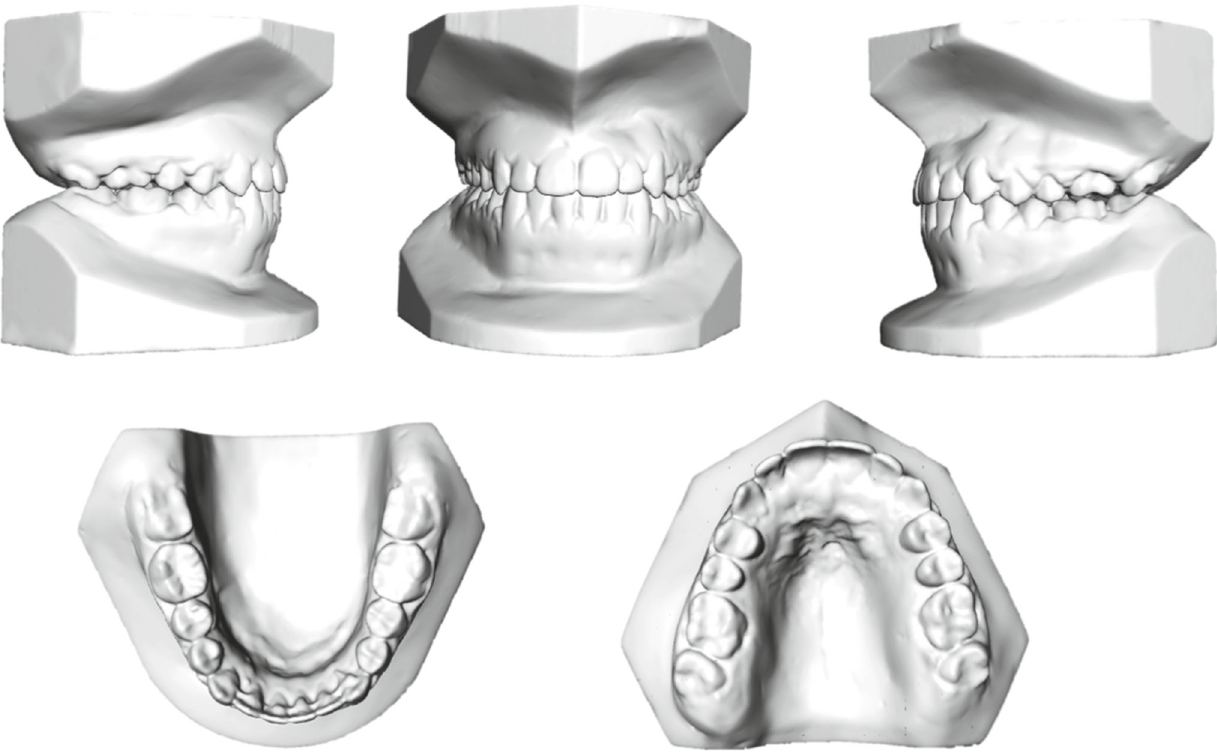
Figure 7: Posttreatment models.